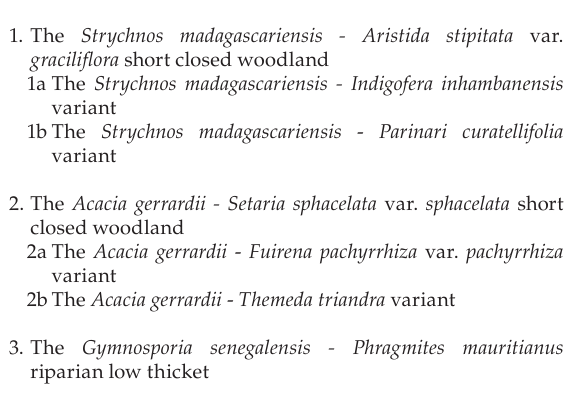
The species groups were arranged to highlight the environmental gradients associated with savanna sandveld ecosystems. The phytosociological classification consists of 12 species groups (A–L) of which 205 (61.7%) and 128 (38.4%) species constitute the diagnostic and non-diagnostic portions, respectively (Table 1). A vegetation map of the AGR providing the spatial occurrence of the plant communities is presented in Fig. 1.